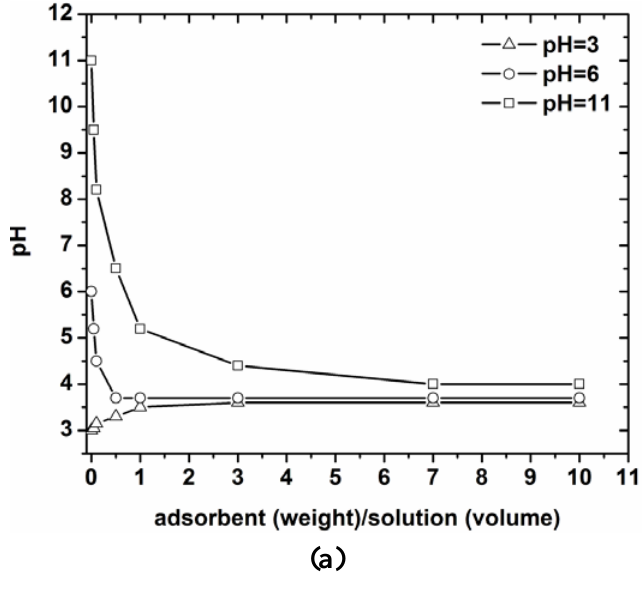
Figure 2. ( a ) Determination of pH Micrograph of coffee